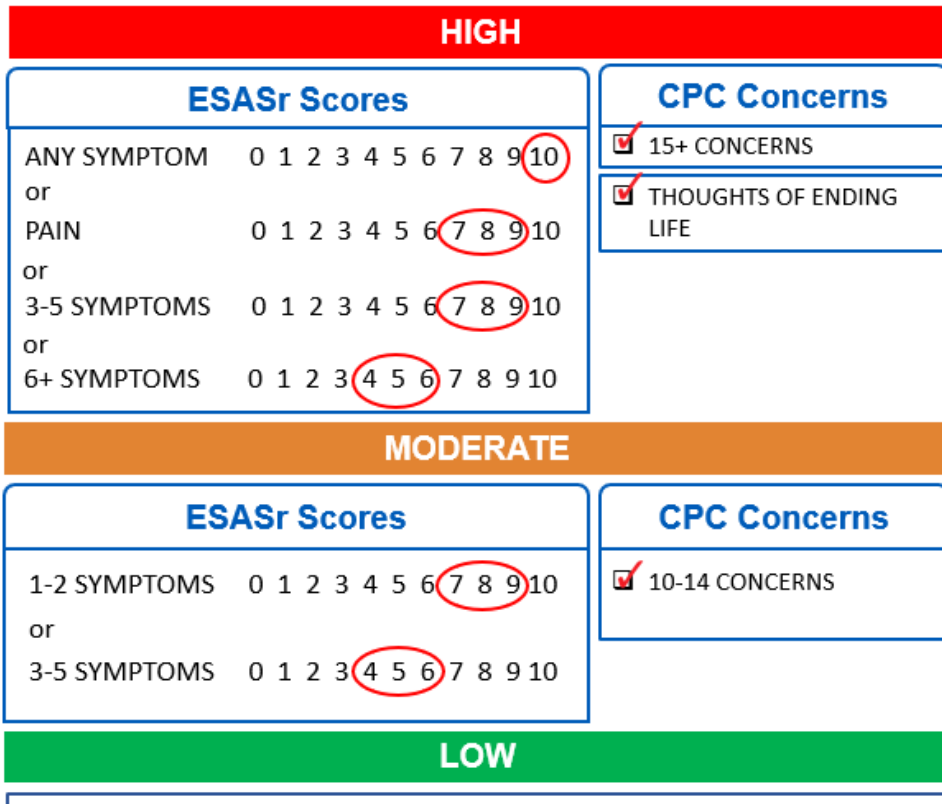
Figure 1. Symptom complexity algorithm.